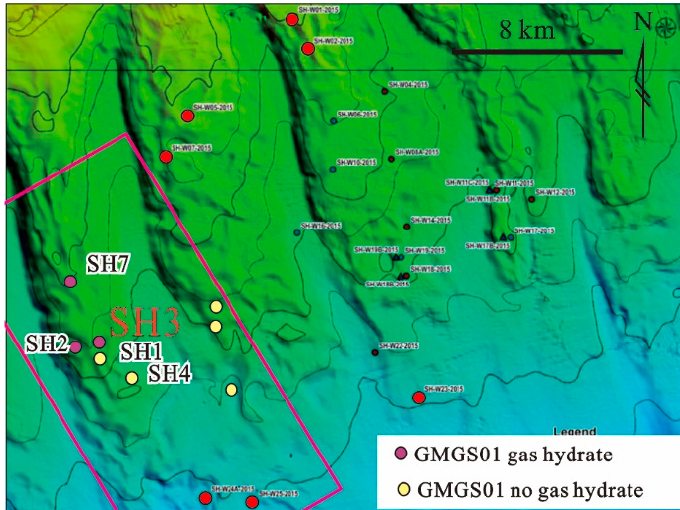
Figure 1. Geological topographic map of the Shenhu area in the northern part of the South China Sea and the location of the core SH3.